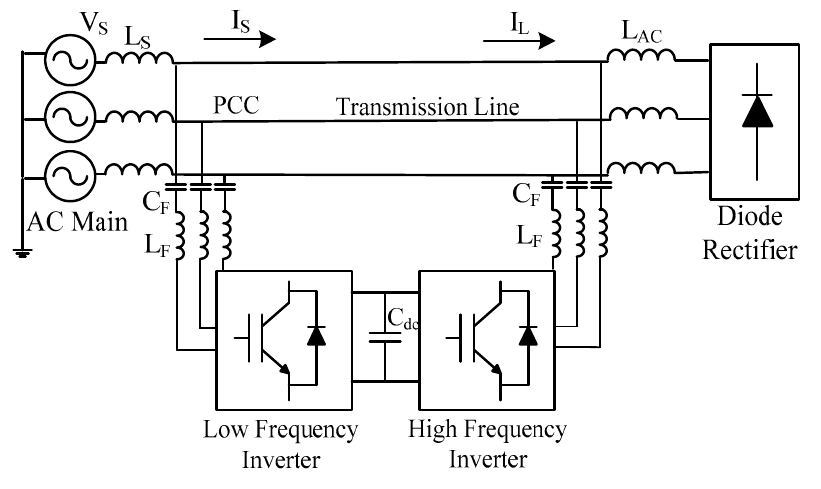
Figure 10. Parallel inverter topology.